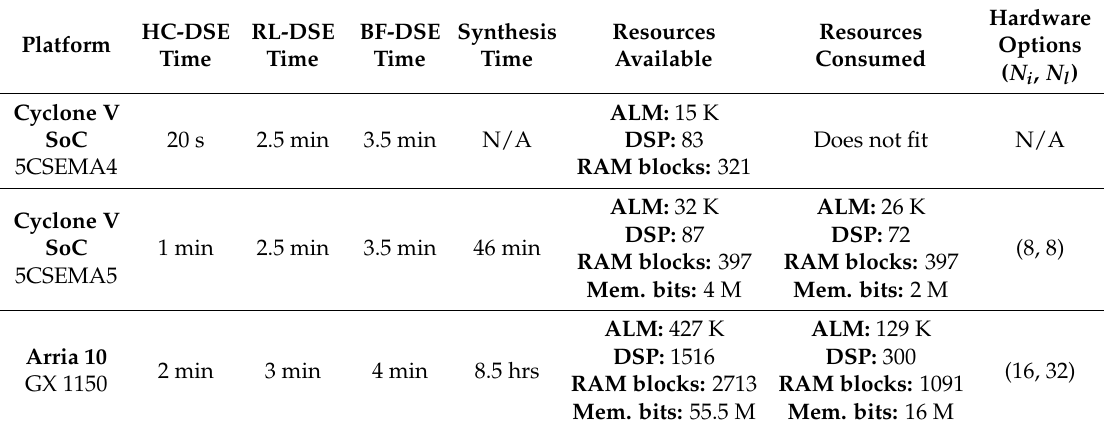
Table 2. CNN2Gate Synthesis and Design-Space Exploration Details